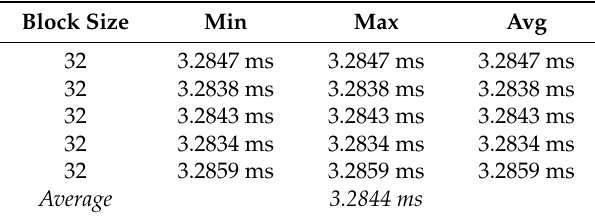
Table 7. Running the nvprof profiler with a block size of 32.